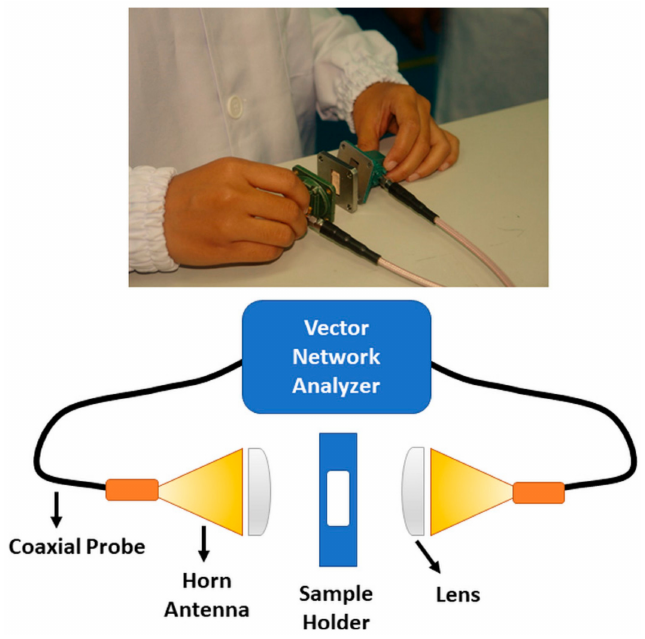
Figure 3. Vector network analyzer to extract the dielectric properties of a